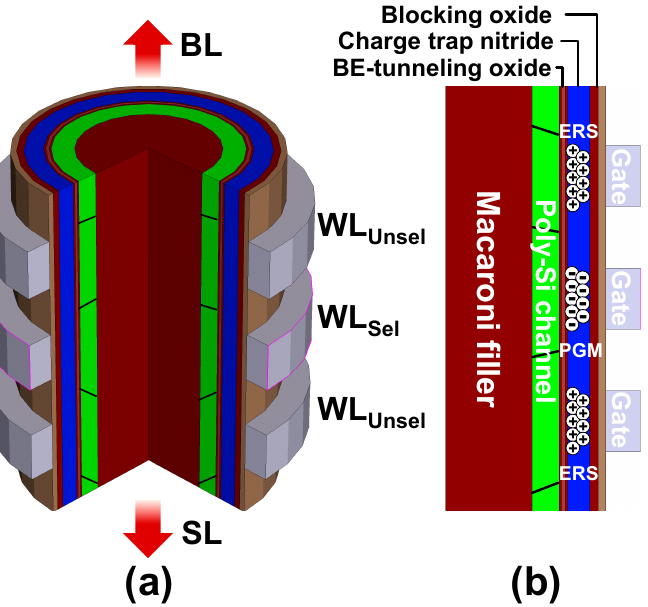
Figure 1. ( a ) Schematic diagram of the cylindrical structure of 3D NAND Flash. ( b ) Half cross-sectional view of string and cell stack. Depending on whether holes or electrons are present in the CTN, the state is ERS or PGM.